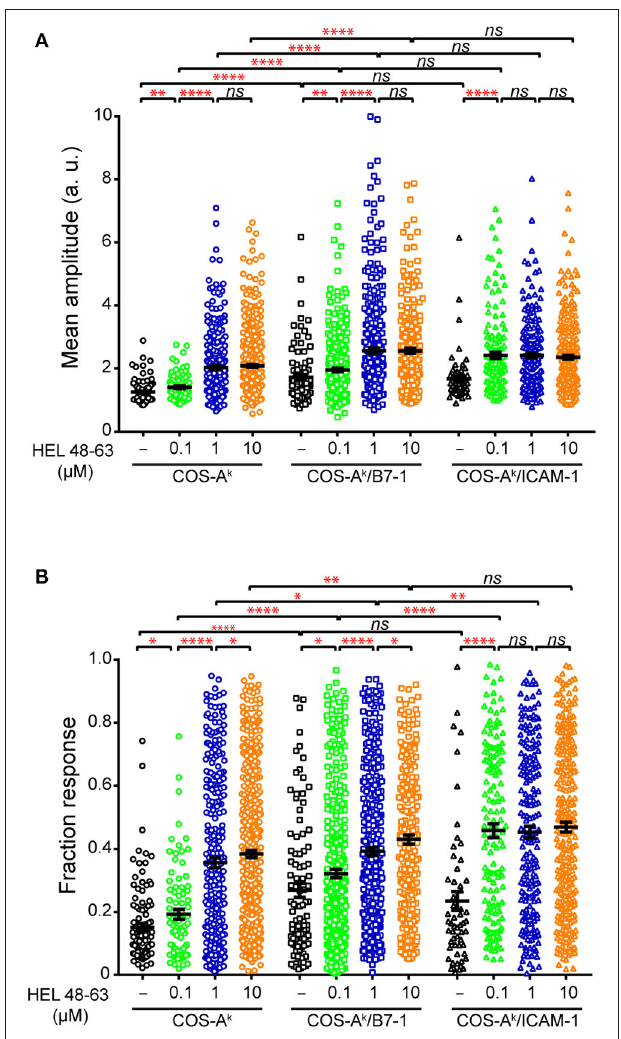
FIGURE 4 | Comparisons of analytical parameters of the calcium response in naive CD4 + T cells upon different stimulation. Naive 3A9 TCRtg CD4 + T cells stained with Fluo-4 PBX were loaded onto COS APC monolayers at 37 ◦ C and observed for 45min. COS-A k , COS-A k /B7-1, COS-A k /ICAM-1 APCs were loaded or not with 0.1, 1, and 10 µ M HEL 48–63. Average mean amplitude (A) and responding fraction (B) were calculated as described in Materials and Methods. Data: mean ± SEM. Mann–Whitney tests were performed using Graphpad prism 7.0 for comparisons between two groups. Statistical significance was set at 0.05, and p -values < 0.05 were denoted in red. * p < 0.05, ** p < 0.01, and **** p < 0.0001.